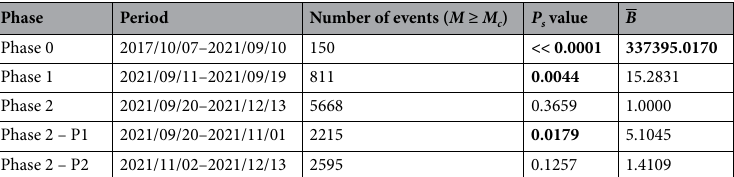
Table 1. Summary of the correlations found between tidal stress and origin time of the events. M c is the magnitude of completeness, which is different in every set or subset of events. See Section “Earthquake data”. P s is the probability that the phase distribution to be random, according to Schuster’s test. B is the upper bound of the Bayes factor calculated as a function of the p -value P s , as told in the “Methods” section. Occurrences where P s < 0.05 or B > 16 are in bold. Note that Phase 2 has been divided in two periods: P1 [2021/09/20–2021/11/01] and P2